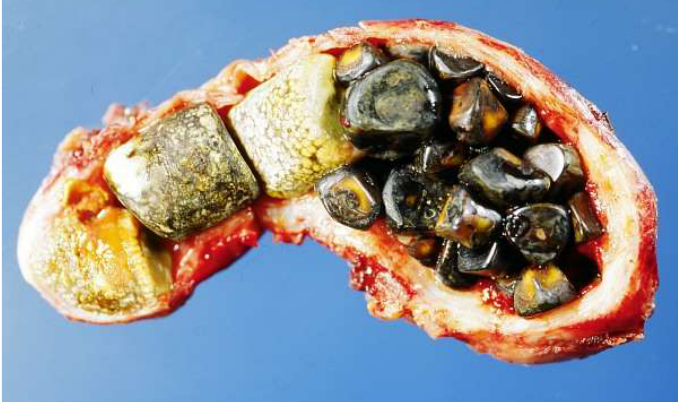
Figure 3. An open gallbladder entirely filled with gallstones (calculi).